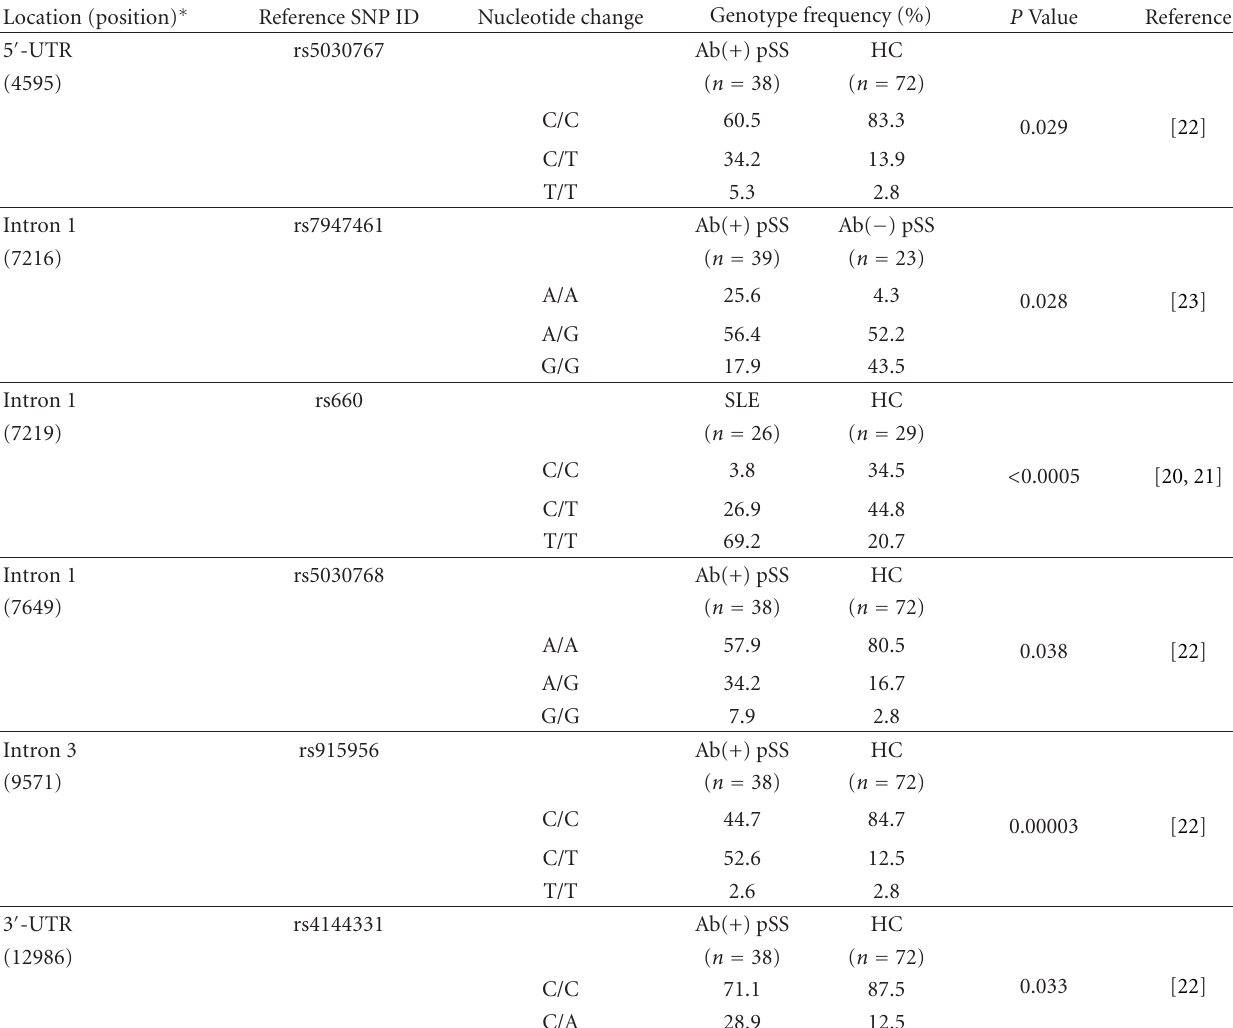
Table 1: SLE/SS-related SNP in TRIM21